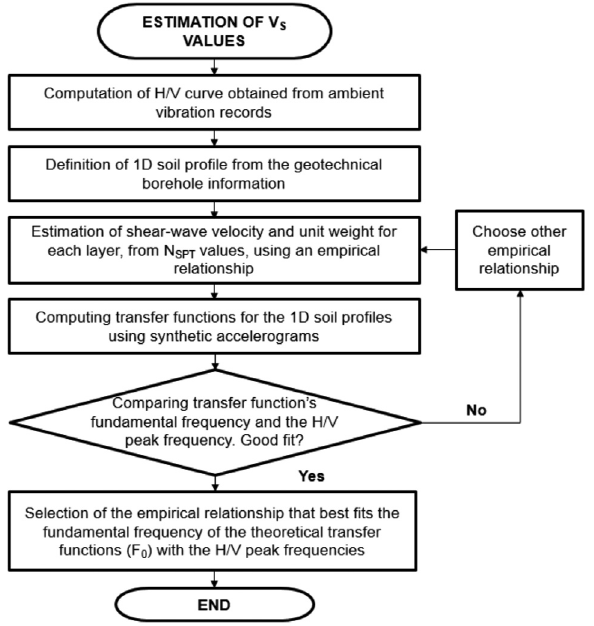
Figure 7. Synthesis of the procedure for estimating the Vs values for each layer. The empirical relationships used are presented in Table 4.